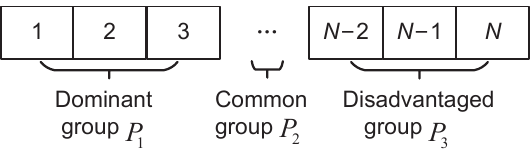
Figure 1. Natural selection of